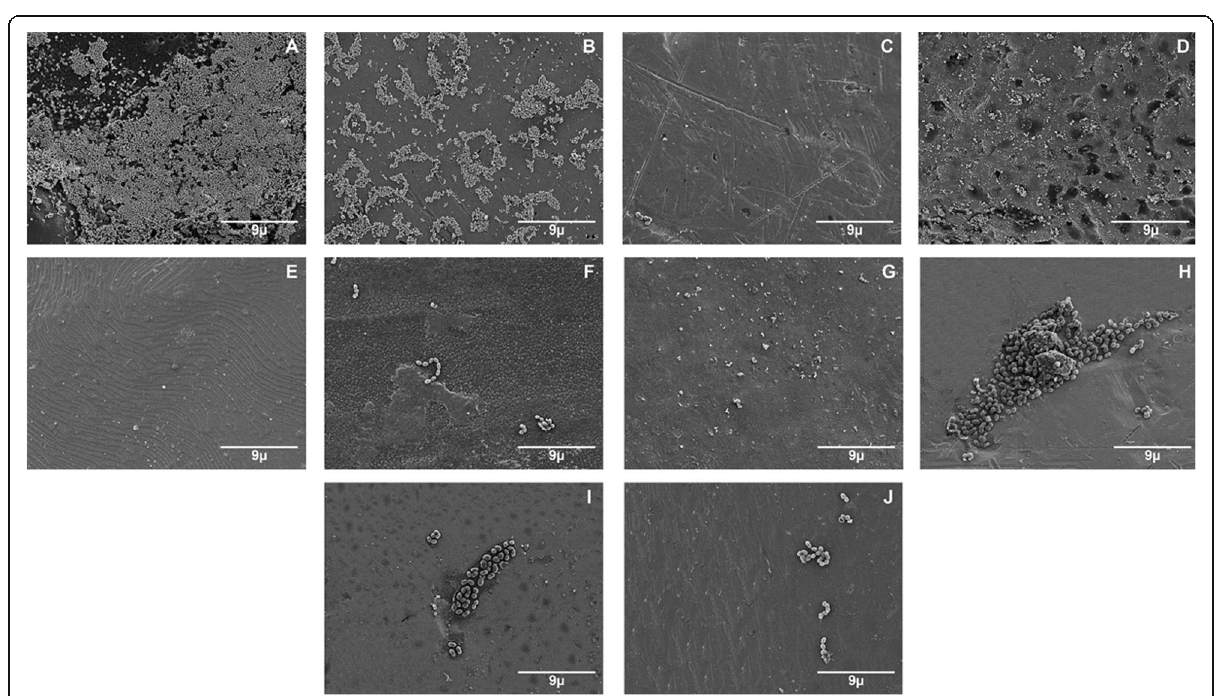
Fig. 2 Representative images from SEM of orthodontic brackets exposed to S.sobrinus (×2500). a GIn. b GIIn. c GIIIn. d GIVn. e GVn. f GVI. g GVII. h GVIII. i GIX. j